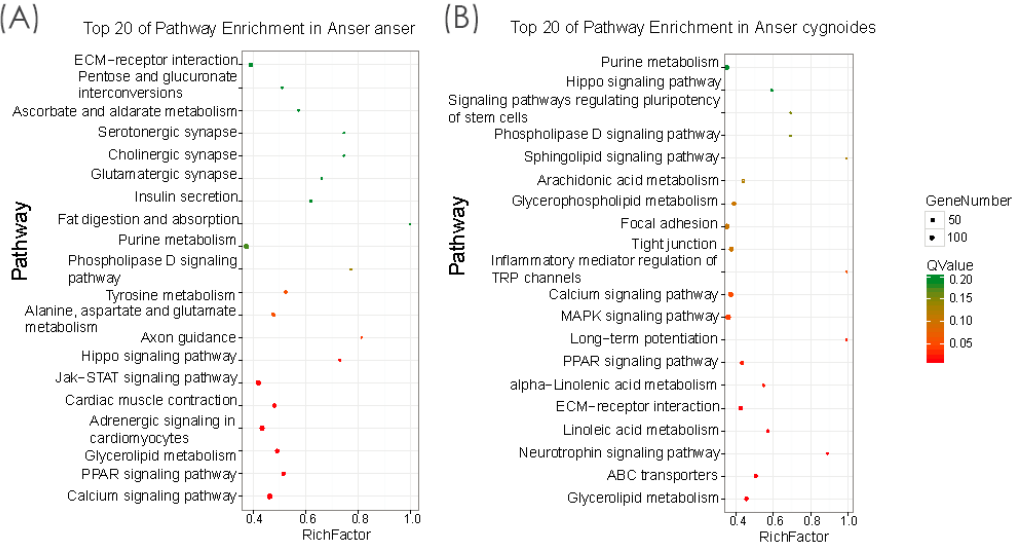
Figure 5. Top 20 enriched KEGG pathways for Anser anser ( A ) and Anser cygnoides ( B ). The y -axis represents the name of the pathway, and the x -axis represents the rich factor and the ratio of the number of DEGs and the number of all genes in the pathway is represented by the rich factor. The Qvalue indicates the significant enrichment of the DEGs and pathways.